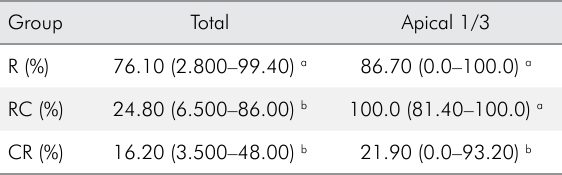
Table. Percentages of residual filling material (median, minimum-maximum) at the whole root canal and apical